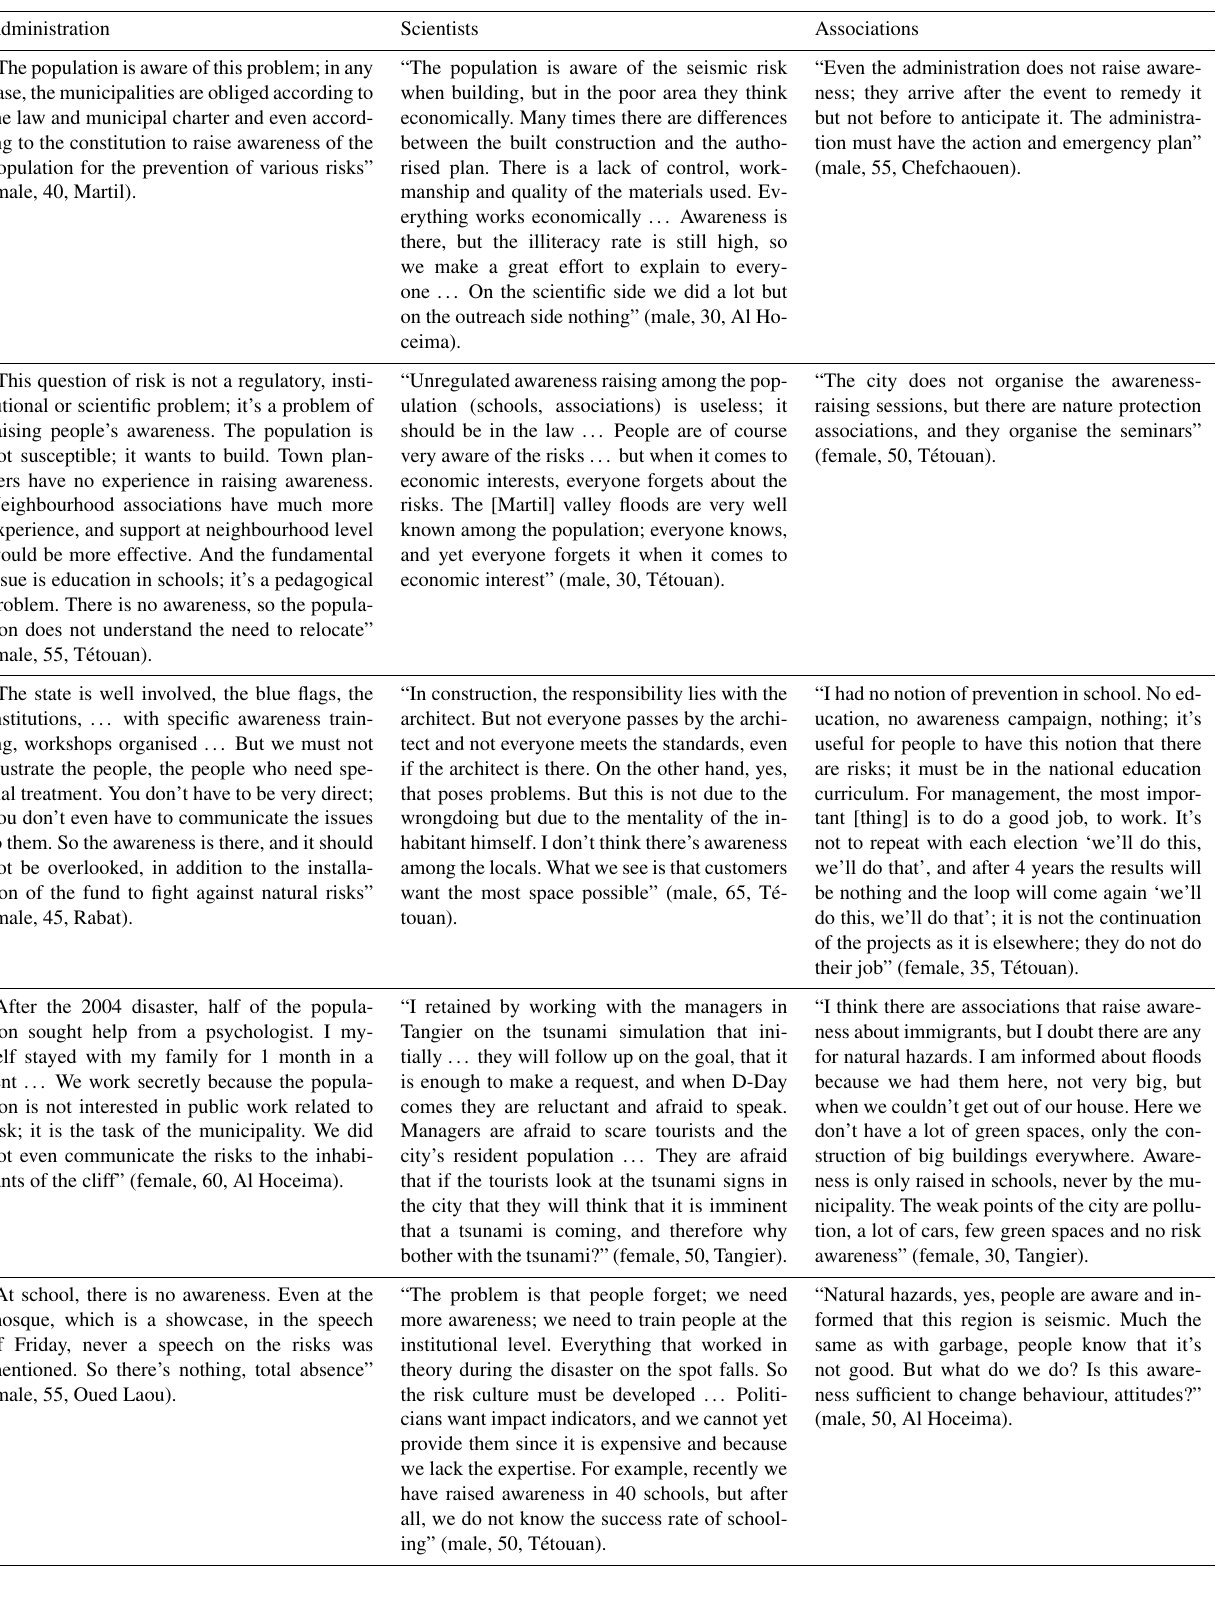
Table 4. Verbatim of stakeholders interviewed regarding risk awareness